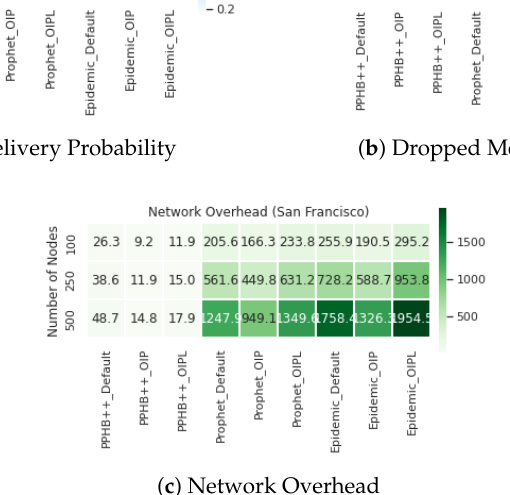
Figure 9. Comparison of ONE default setting with Optimized parameters for San Francisco dataset (The MDP and DMP parameters are normalized to a scale between 0 and 1).